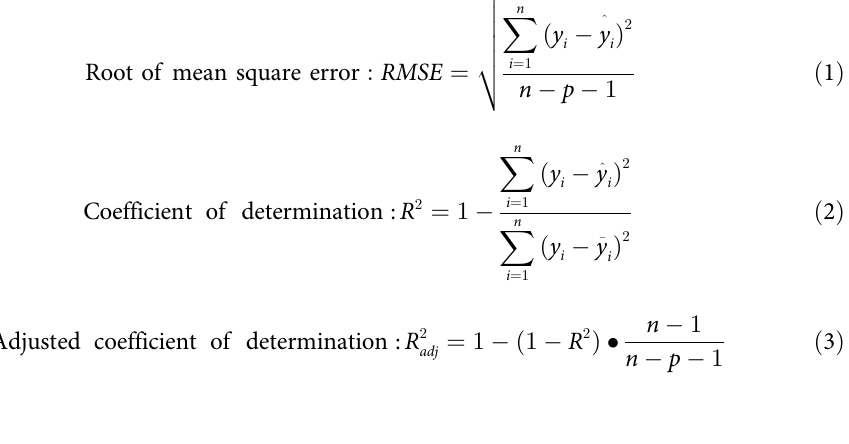
Model evaluation and comparison were based on graphical and numerical analysis of the values of the following statistics: 1) root of mean square error (RMSE) (Eq 1), which analysed the precision of the estimates (the smaller, the better); 2) adjusted coefficient of determination (R 2 adj) (Eqs 2 and 3), which reflected the part of the total variance explained by the model and which took into account the number of parameters that were necessary in making the estimates (the greater the value, the higher the interrelation between the variables); 3) bias (Eq 4) and rel- ative bias (Eq 5), which evaluated the deviation of the model with respect to the observed re- sults (the smaller, the better); and 4) Akaike ’ s information criterion (AIC) (Eq 6 and Eq 7), which is a commonly used information criterion and which was used to select the best model (as a rule, the model with the lower AIC values was preferred). The expressions for these statis- tics are as follows: Root of mean square error : RMSE ¼ Coefficient of determination : R 2 ¼ 1 (cid:3) Adjusted coefficient of determination : R 2